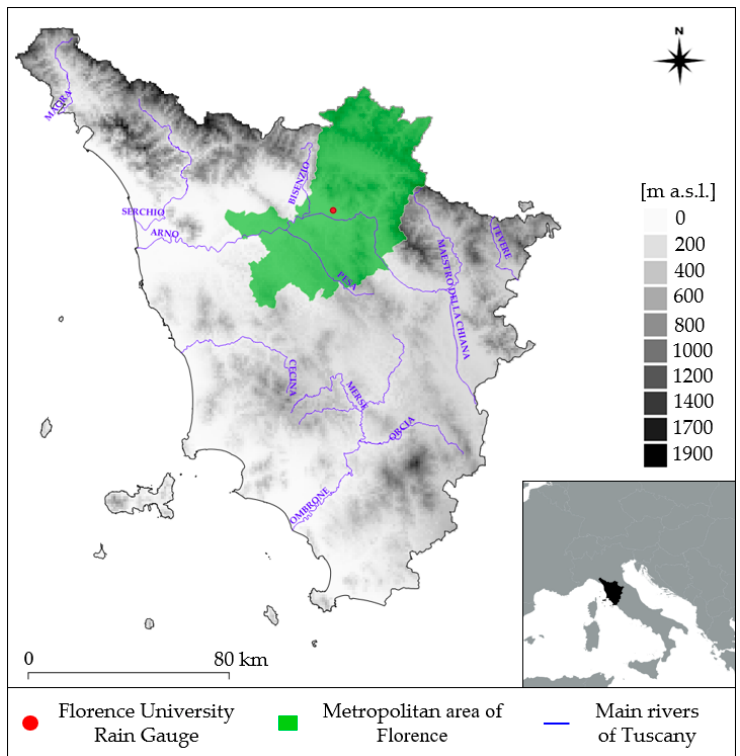
Figure 1. Location of the study case on a Digital Terrain Model (DTM) with a grid resolution of 10 m. The red dot indicates the rainfall gauge location within the Metropolitan Area of Florence.